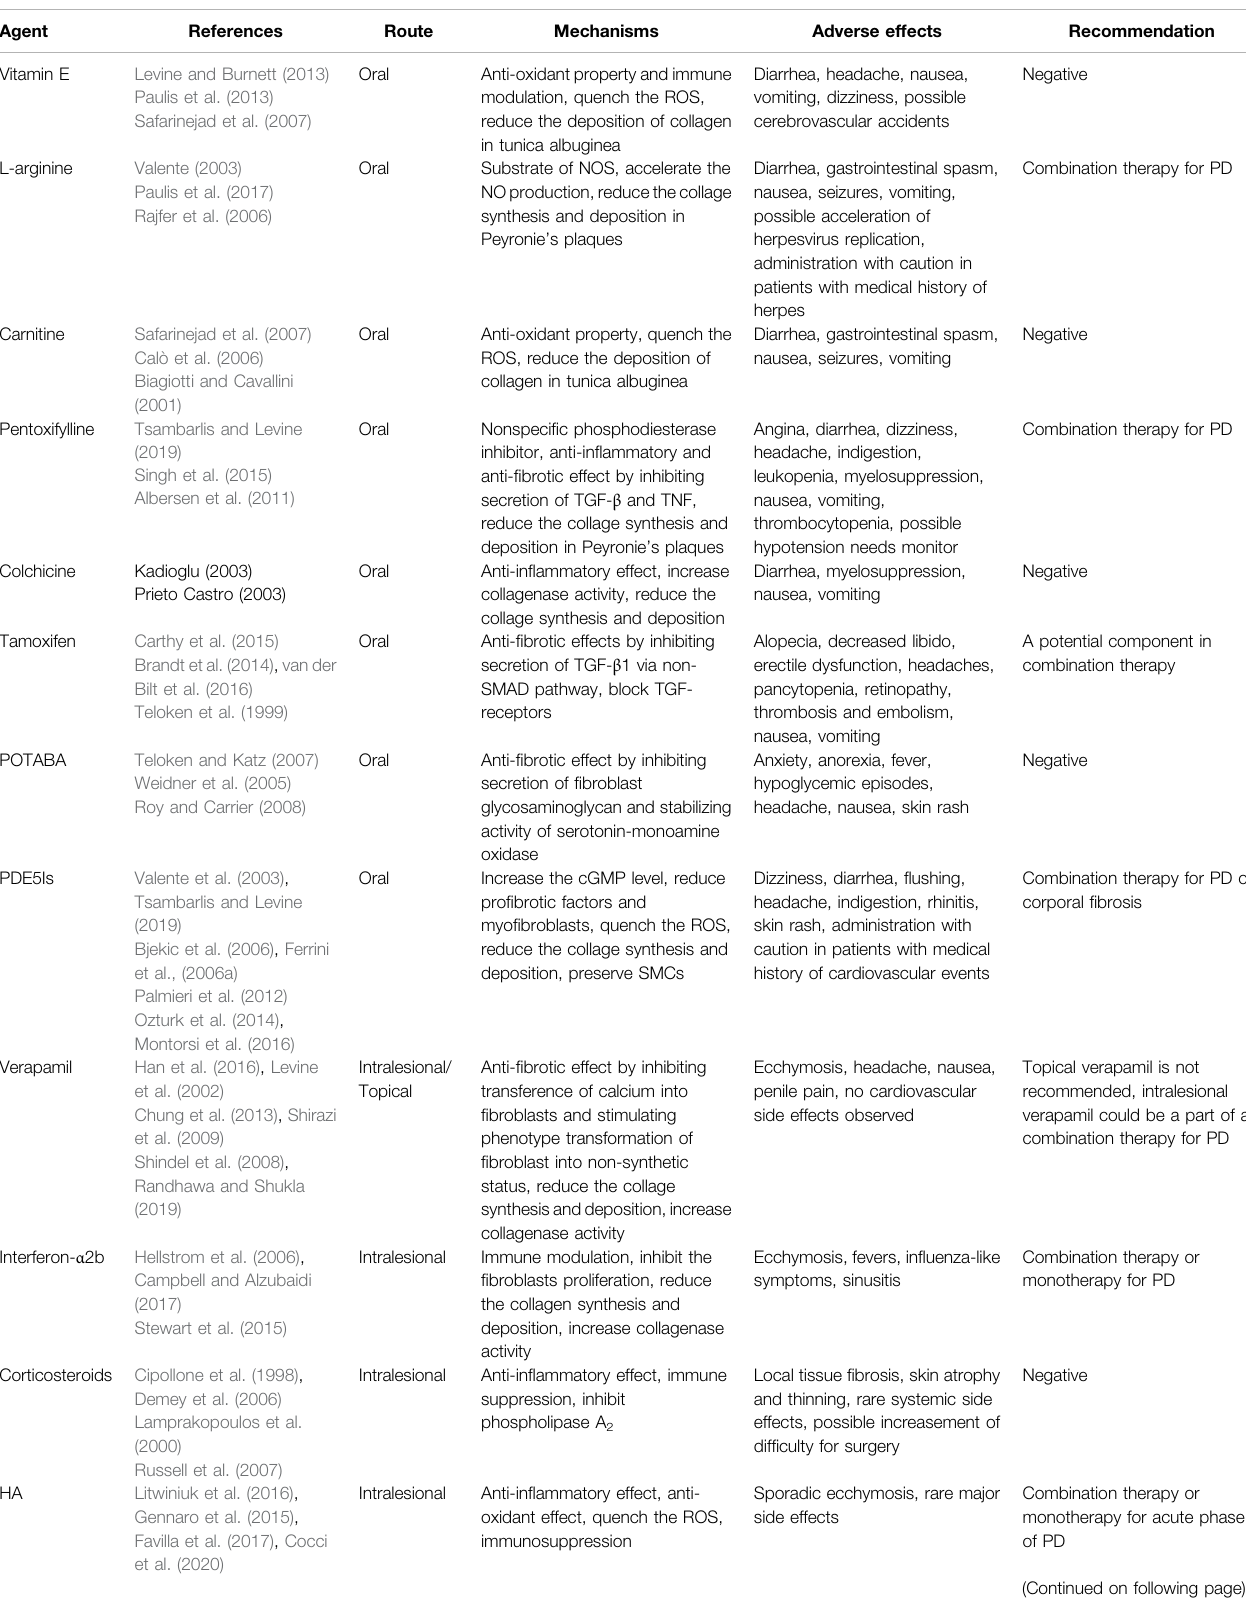
TABLE 1 | Current and potential pharmacotherapy for Peyronie ’ s